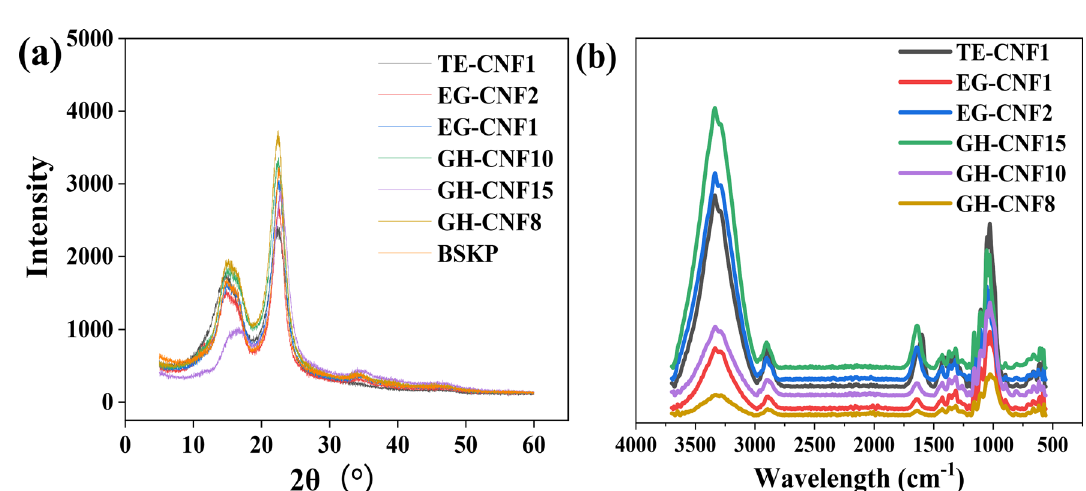
Figure 4. Length distributions of CNFs manufactured by different methods, ( a ) GH-CNF8, ( b ) GH-CNF10, ( c ) GH-CNF15, ( d ) EG-CNF1, ( e ) EG-CNF2, ( f ) TE-CNF1.